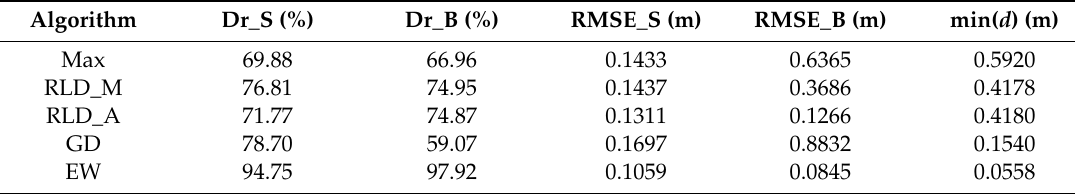
Table 4. Performance assessments for detection results in shallow water with simulated data.